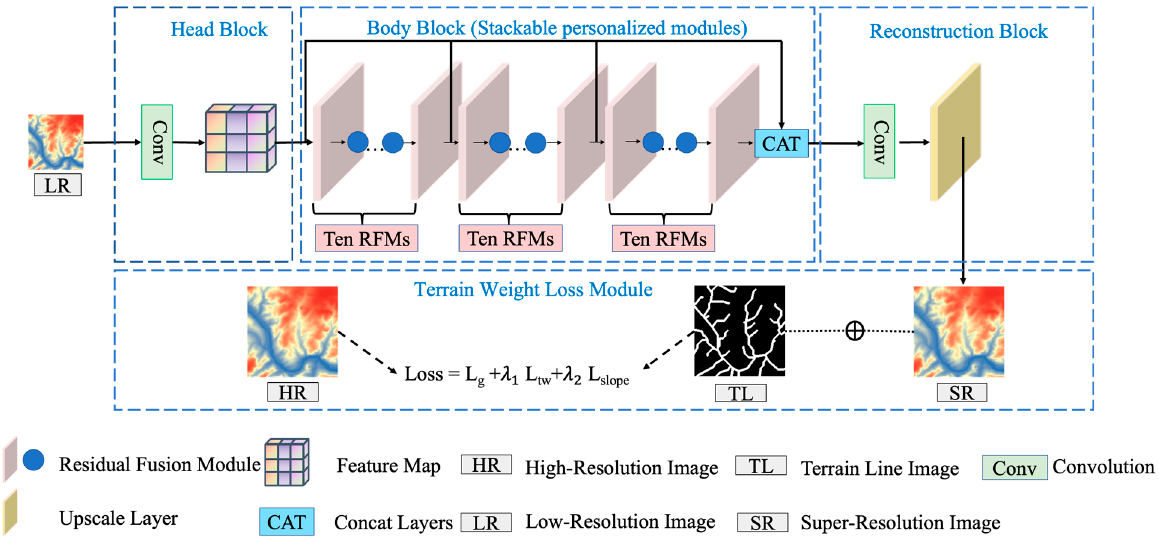
Figure 2. Overview of the proposed enhanced residual feature fusion network (ERFFN).